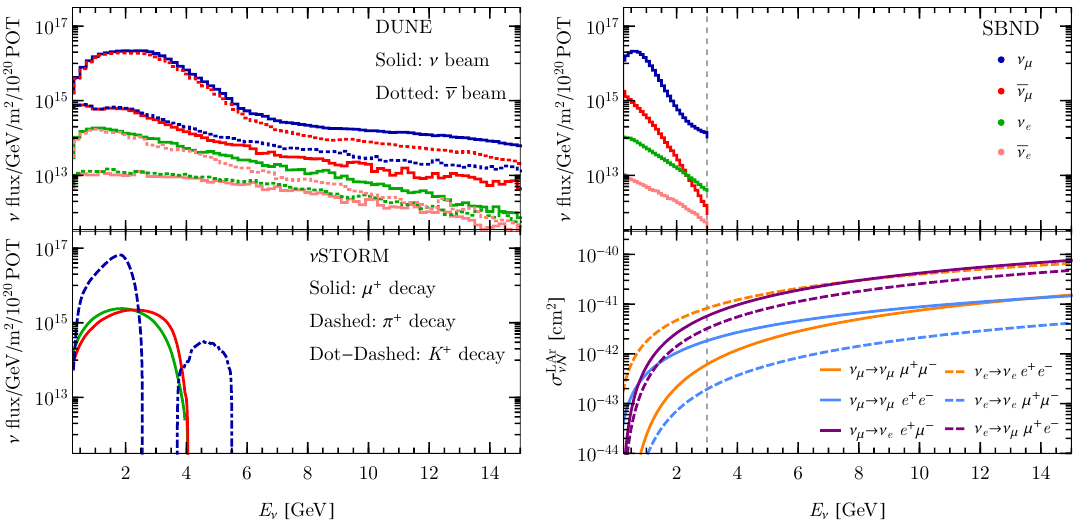
Figure 7 . Energy distribution of the neutrino (cid:13)uxes at the position of the LAr detectors DUNE (top left, [42]), SBND (top right, [20]) and (cid:23) STORM (bottom left, [24]) and of the cross sections for the various trident modes (bottom right). The (cid:13)uxes at (cid:22) BooNE and ICARUS are similar to the one shown for SBND when normalized over